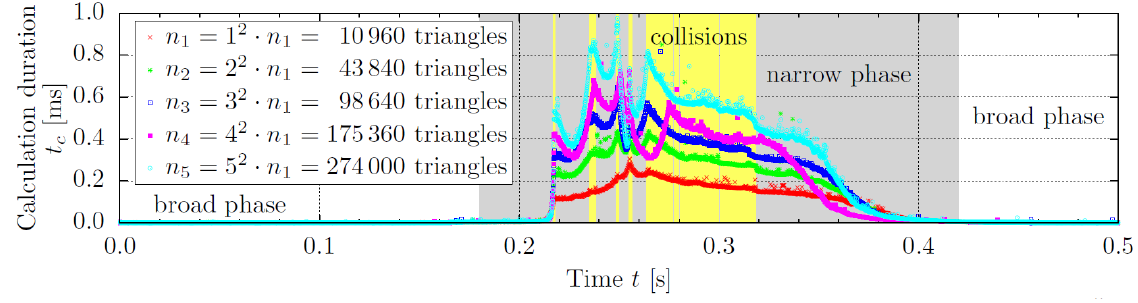
Figure 15. Performance of ODE’s collision detection method, coupled to ELBE , ∆ t = 10 − 5